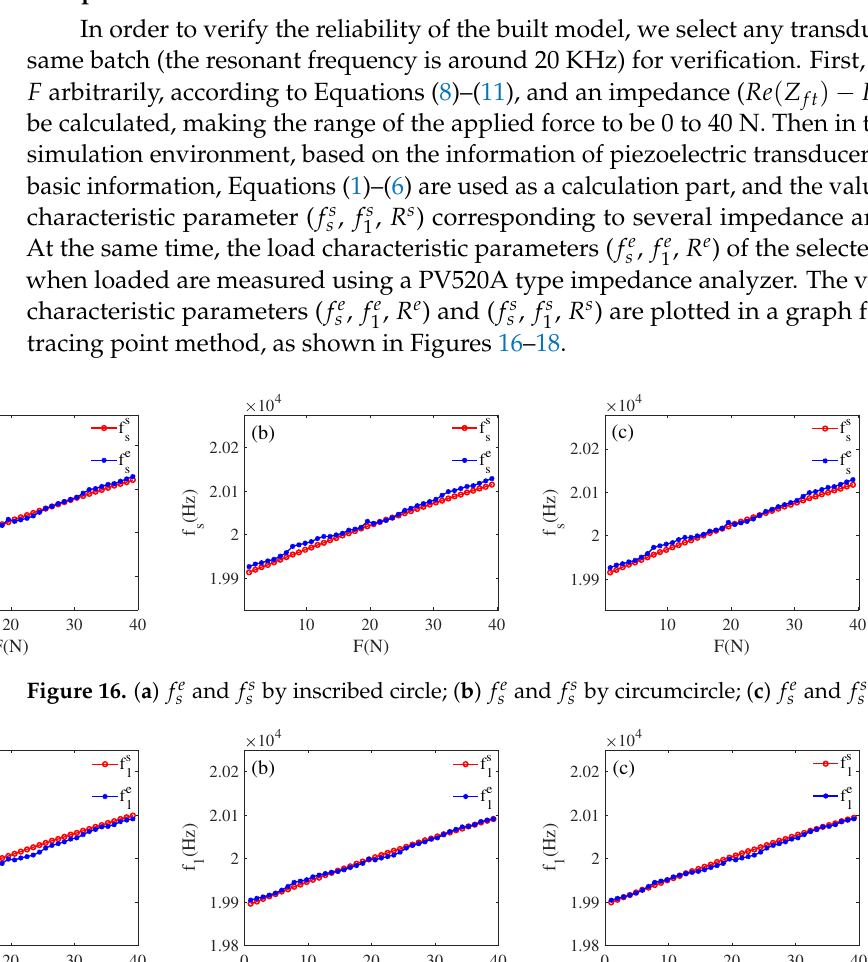
by circumcircle; ( c ) f e and f s 1 1